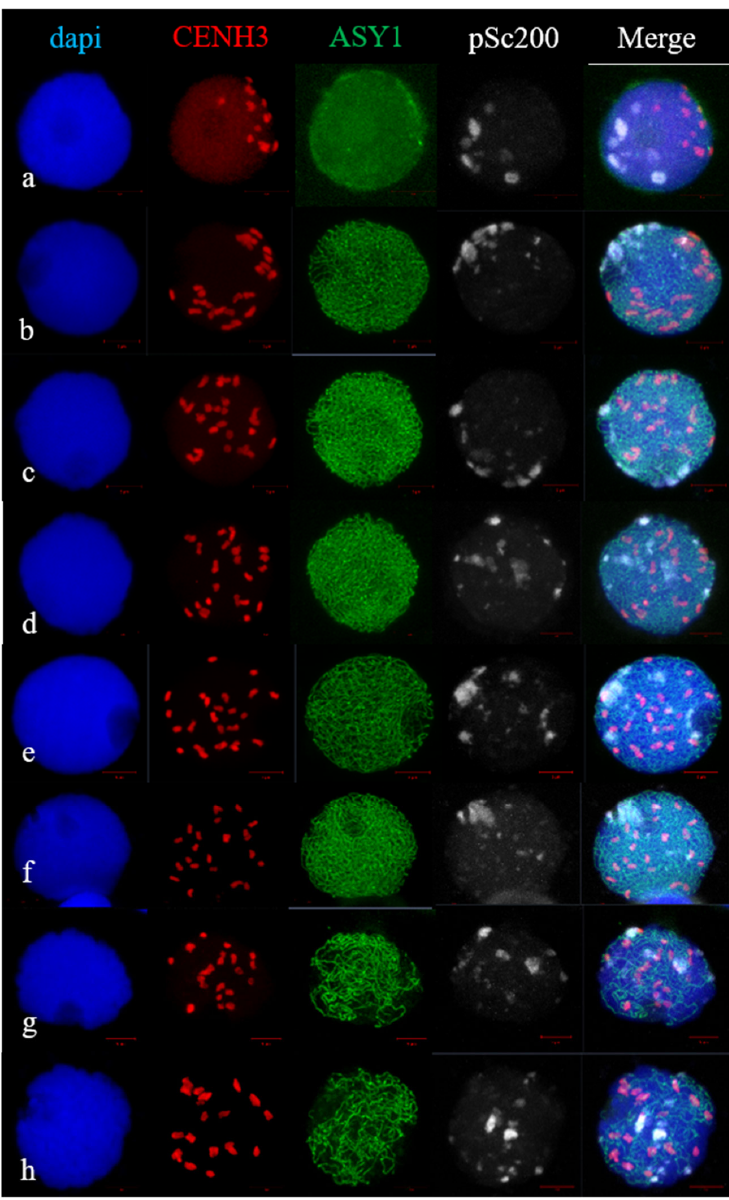
Figure 6. CENH3 and pSc200 behaviour at leptotene-to-pachytene stages, marked by ASY1 loading in 1R(1A) × R hybrids. ( a ) Leptotene. CENH3 indicates centromere clustering, ASY1 signals form part of circular arc, subtelomeres form clumps and occupy a circular arc. ( b – f ) Zygotene. ASY1 signals are visible along chromatin axes. ( b ) Centromeres and subtelomeres are polarized and occupy circular arcs. ( c ) Centromeres distributed over nucleus, subtelomeres formed part of circular arc. ( d , e ) Large and small subtelomere clumps as well as centromeres distributed over nucleus. ( f ) Centromeres distributed over nucleus, subtelomeres are associated in cluster. ( g ) Late zygotene–early pachytene. Initiation of ASY1 disassembly, subtelomeres distributed over the nucleus. ( h ) Pachytene. ASY1 disassembly, subtelomeres distributed over the nucleus. ImmunoFISH. Confocal image, maximum intensity projection. Scale bar = 5 μ m.